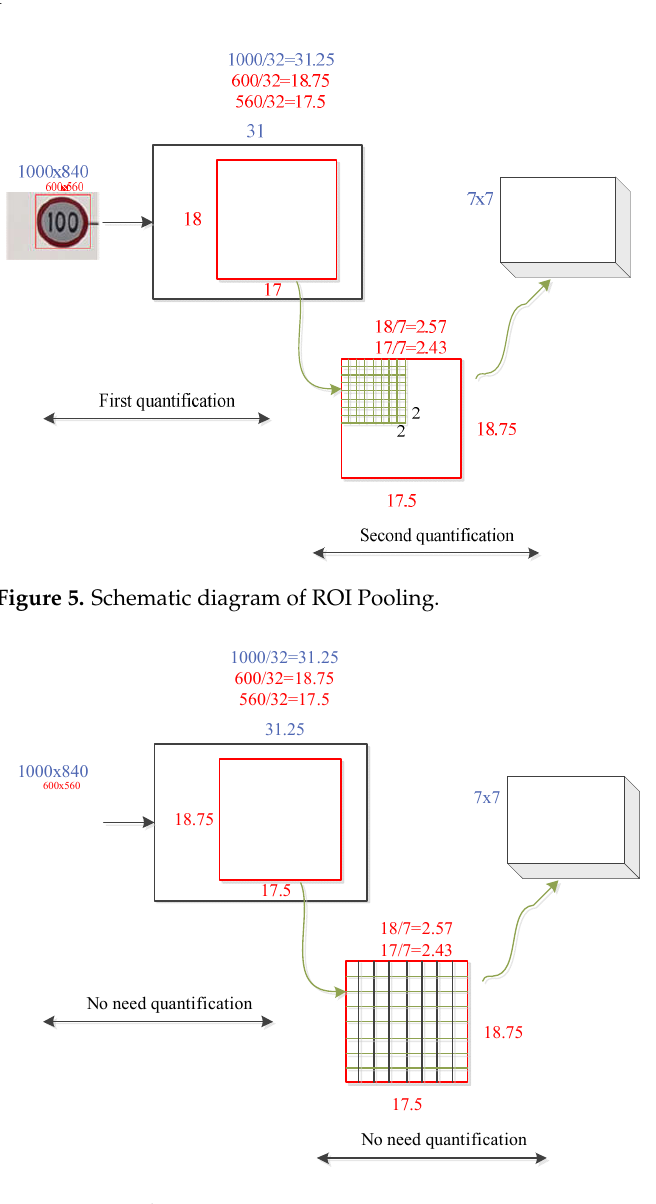
Figure 6. ROI align process.